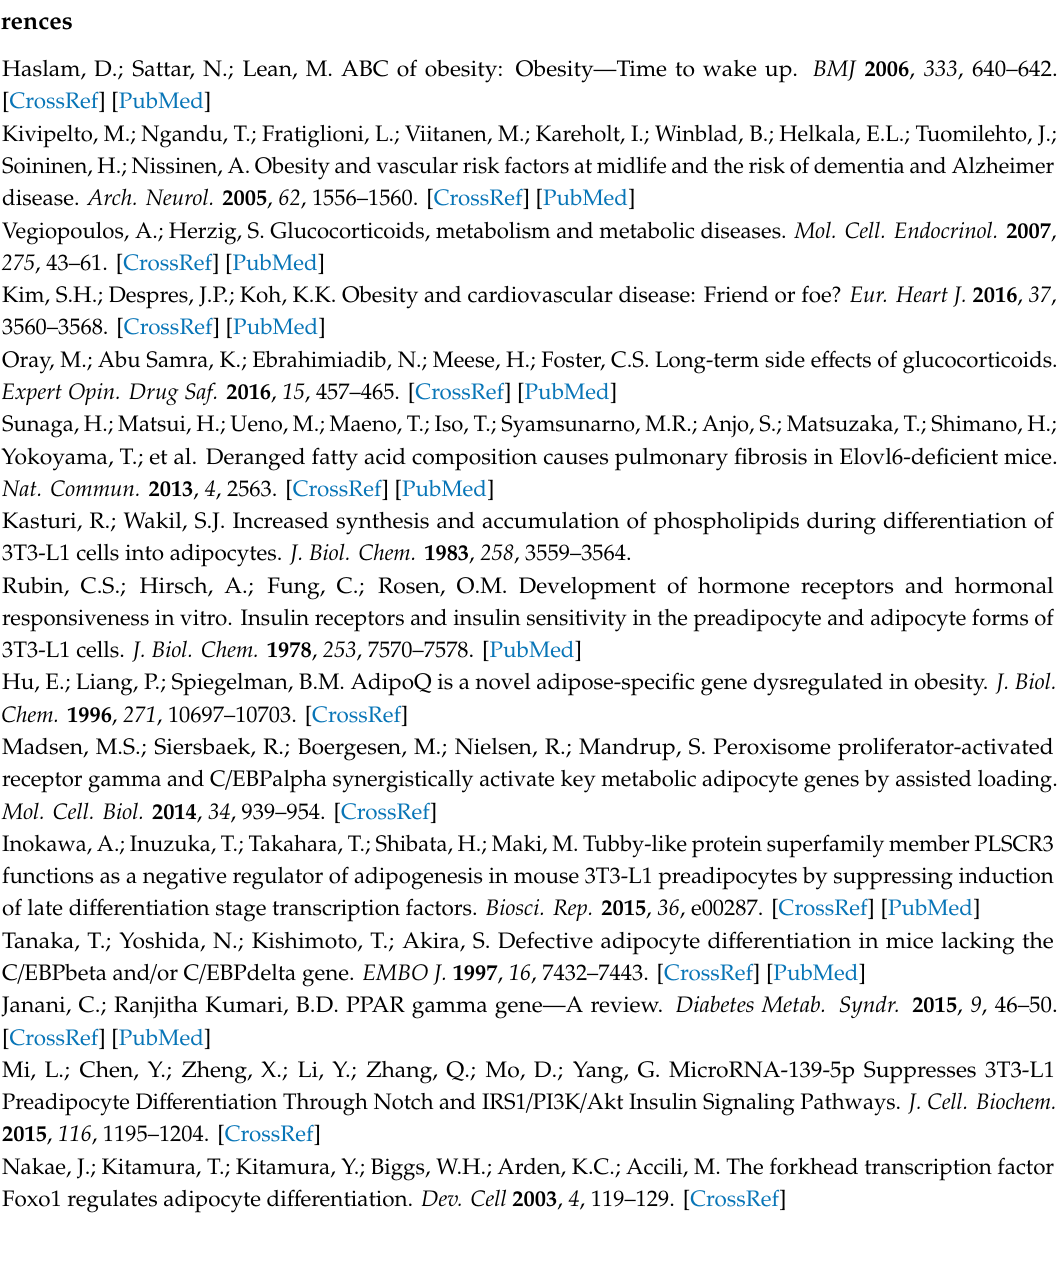
Figure S1: 3D-HPLC diagram of KSS, Figure S2: PR, MC, GLR, MH change in lipid droplets, Figure S3: PR, MC, GR, MH reduce lipid accumulation in a dose-dependent manner, Figure S4: EU, SG major components of KSS reduce fat accumulation in a dose-dependent manner, Table S1: Composition of ten herbs of KSS, Table S2: Eight major compounds of